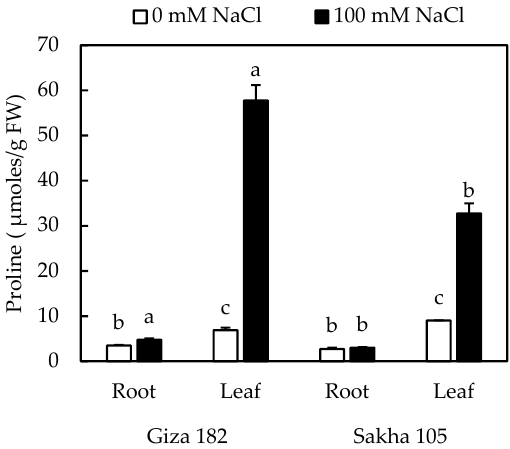
Figure 4. Proline concentration in the roots and leaves of Giza 182 and Sakha 105 under control conditions and 100 mM NaCl stress for 14 days. Data represent the means ± SE (standard errors) ( n = 4). FW: fresh weight. The bars with same letter on the top are not significantly different ( p ≤ 0.05).